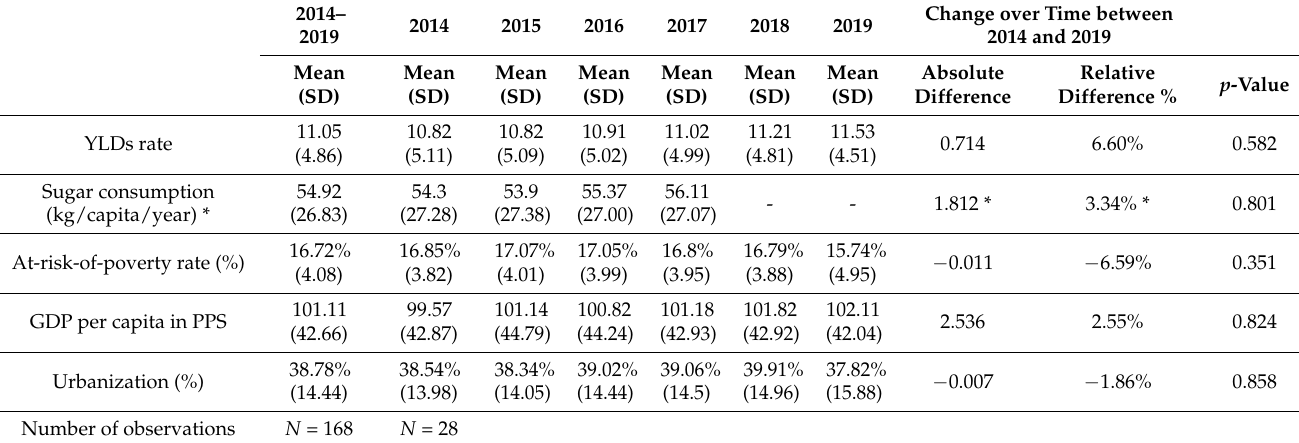
Table 1. Mean change in YLDs and covariates over time (2014–2019).